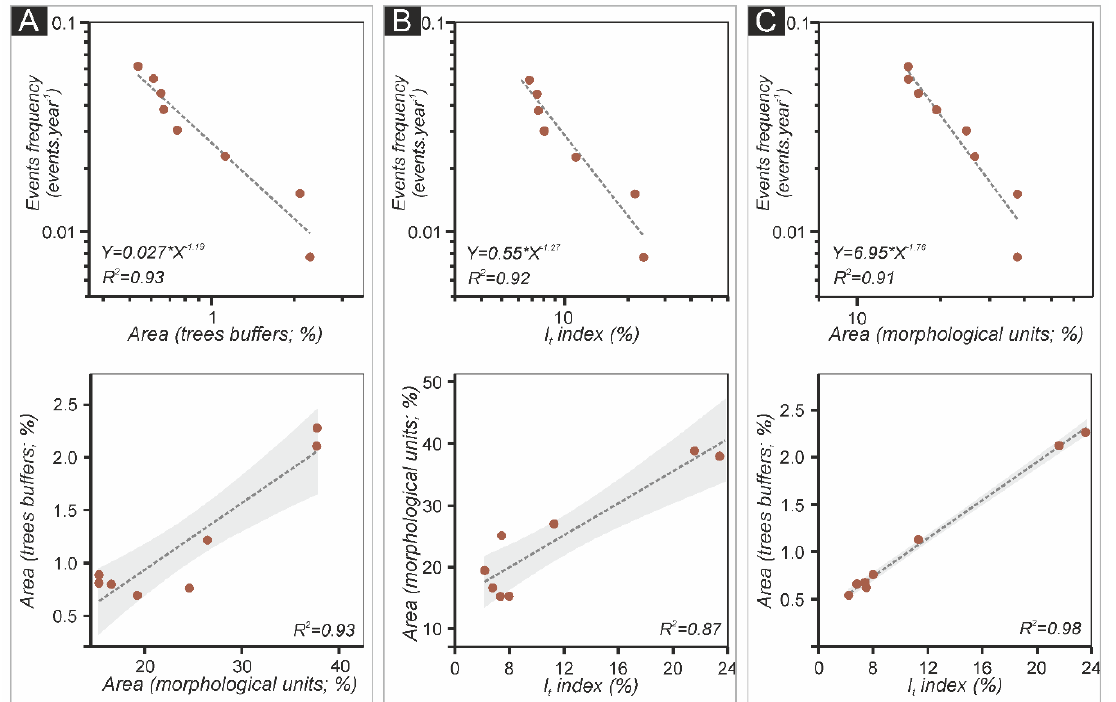
Figure 8. The magnitude–frequency relationships of the Lipová stráň landslide, and the relationships among the methods of expressing magnitude ( A – relationships for trees buffers based area, B – relationships for I t index, C – relationships for morphological units based area).